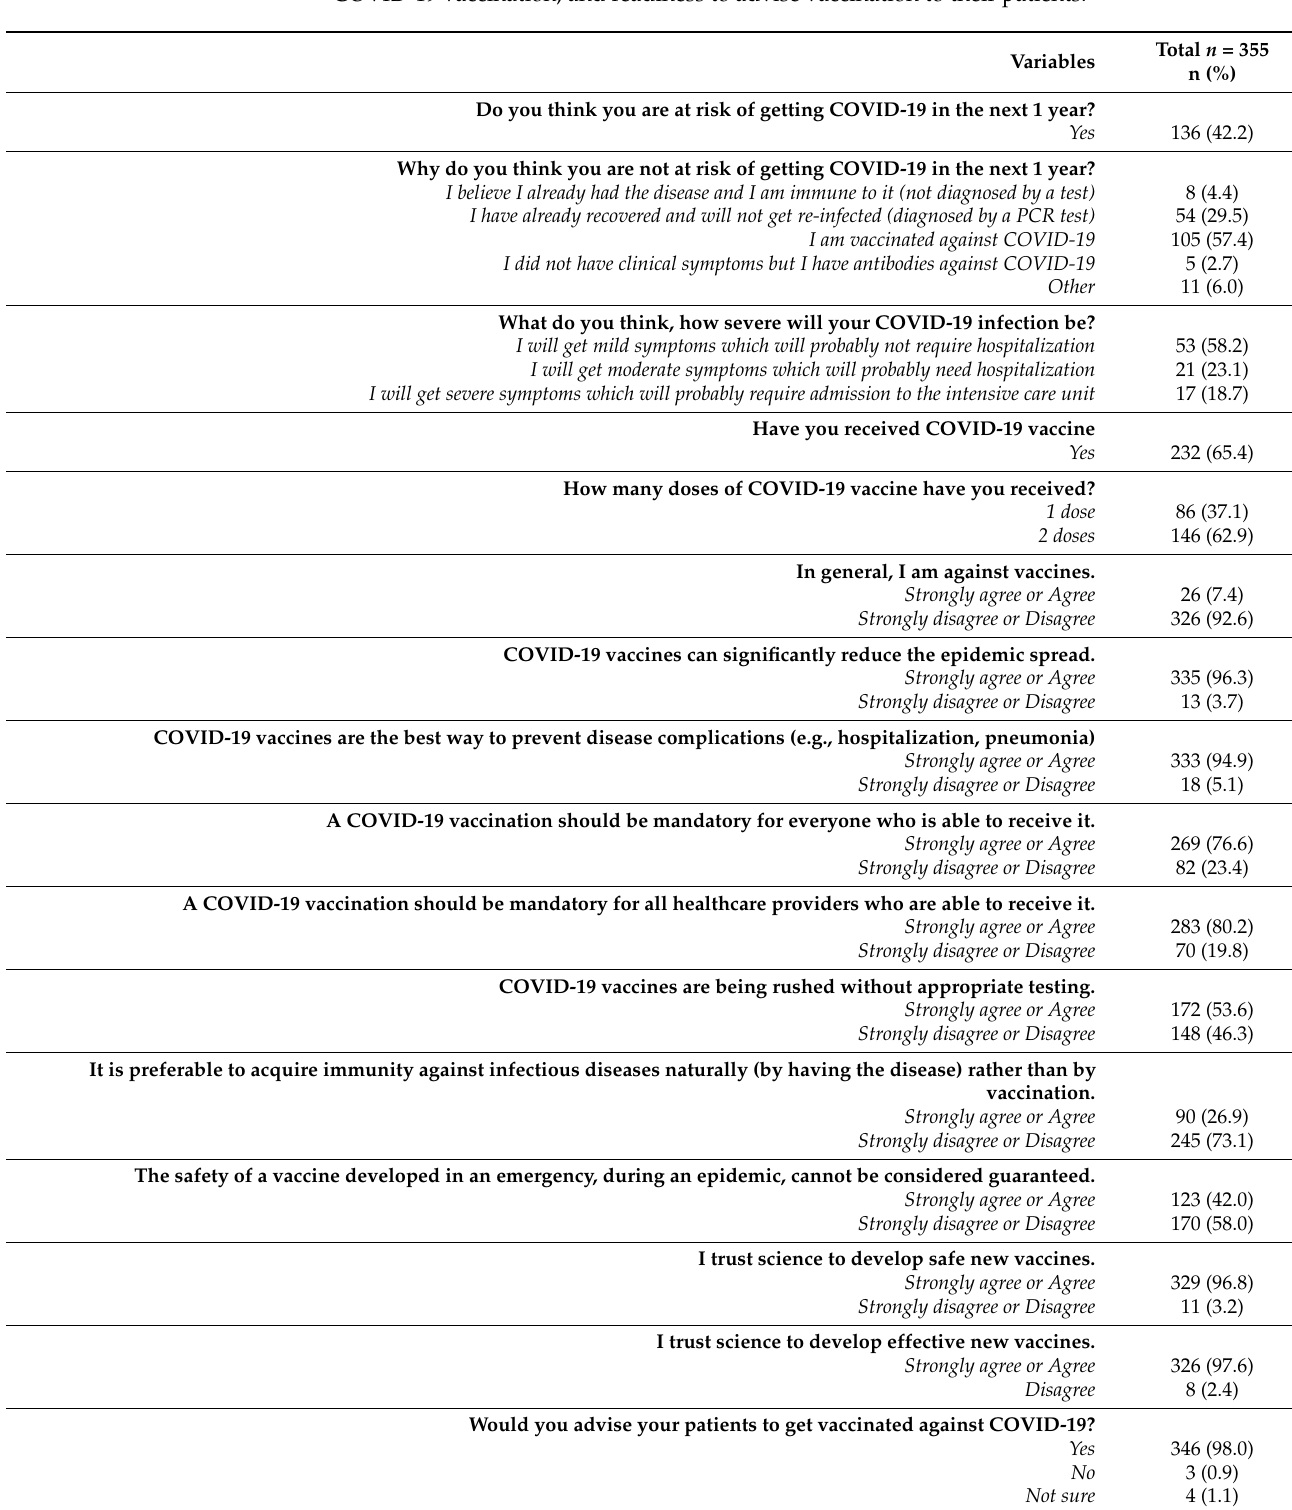
Table 3. PHC providers’ perceived risk of getting COVID-19, vaccination status, attitude toward COVID-19 vaccination, and readiness to advise vaccination to their